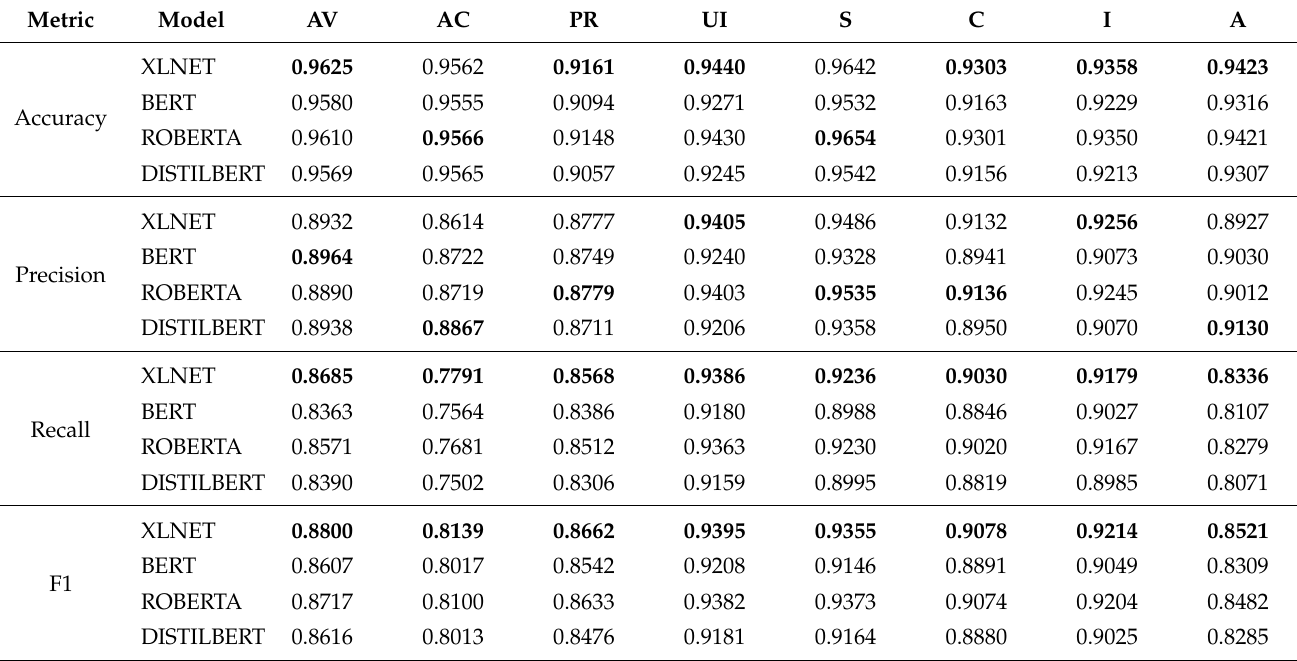
Table 4. Comparison of the effects of the four pre-trained models on the CVSS v3.1 dataset.